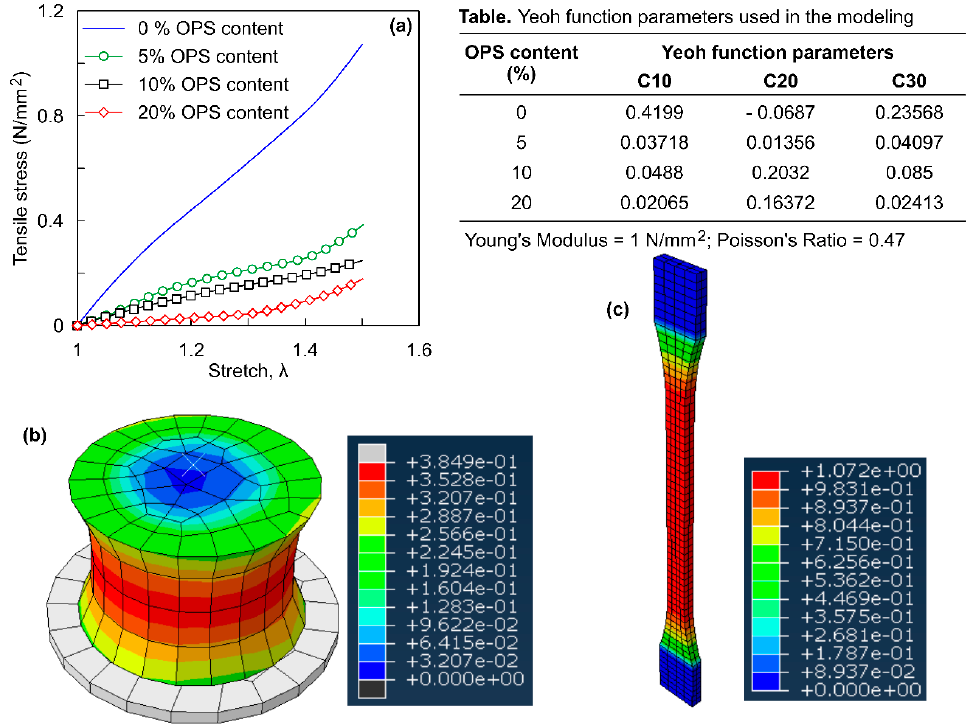
Figure 4. FE simulation of specimen under tension: ( a ) stress-stretch response of ROPS specimen; ( b ) tensile stress contours of ROPS with 5% OPS; ( c ) tensile stress contour of dumbbell shaped rubber.